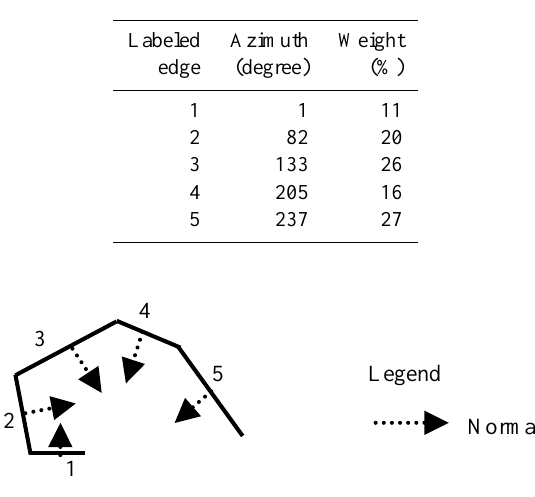
Table 2. Quantitative description of direction relations from R to V in Fig. 8.